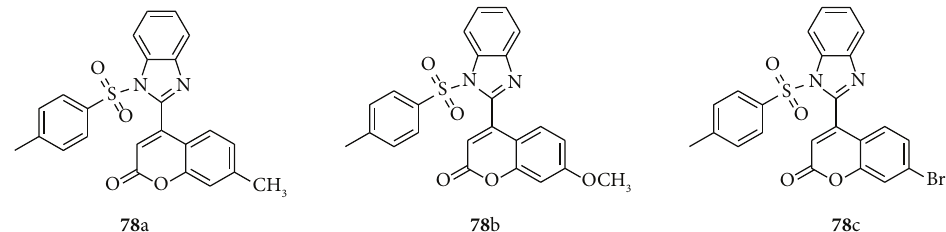
Figure 8: Chemical structures of anti-inflammatory active benzimidazole-sulfonyl